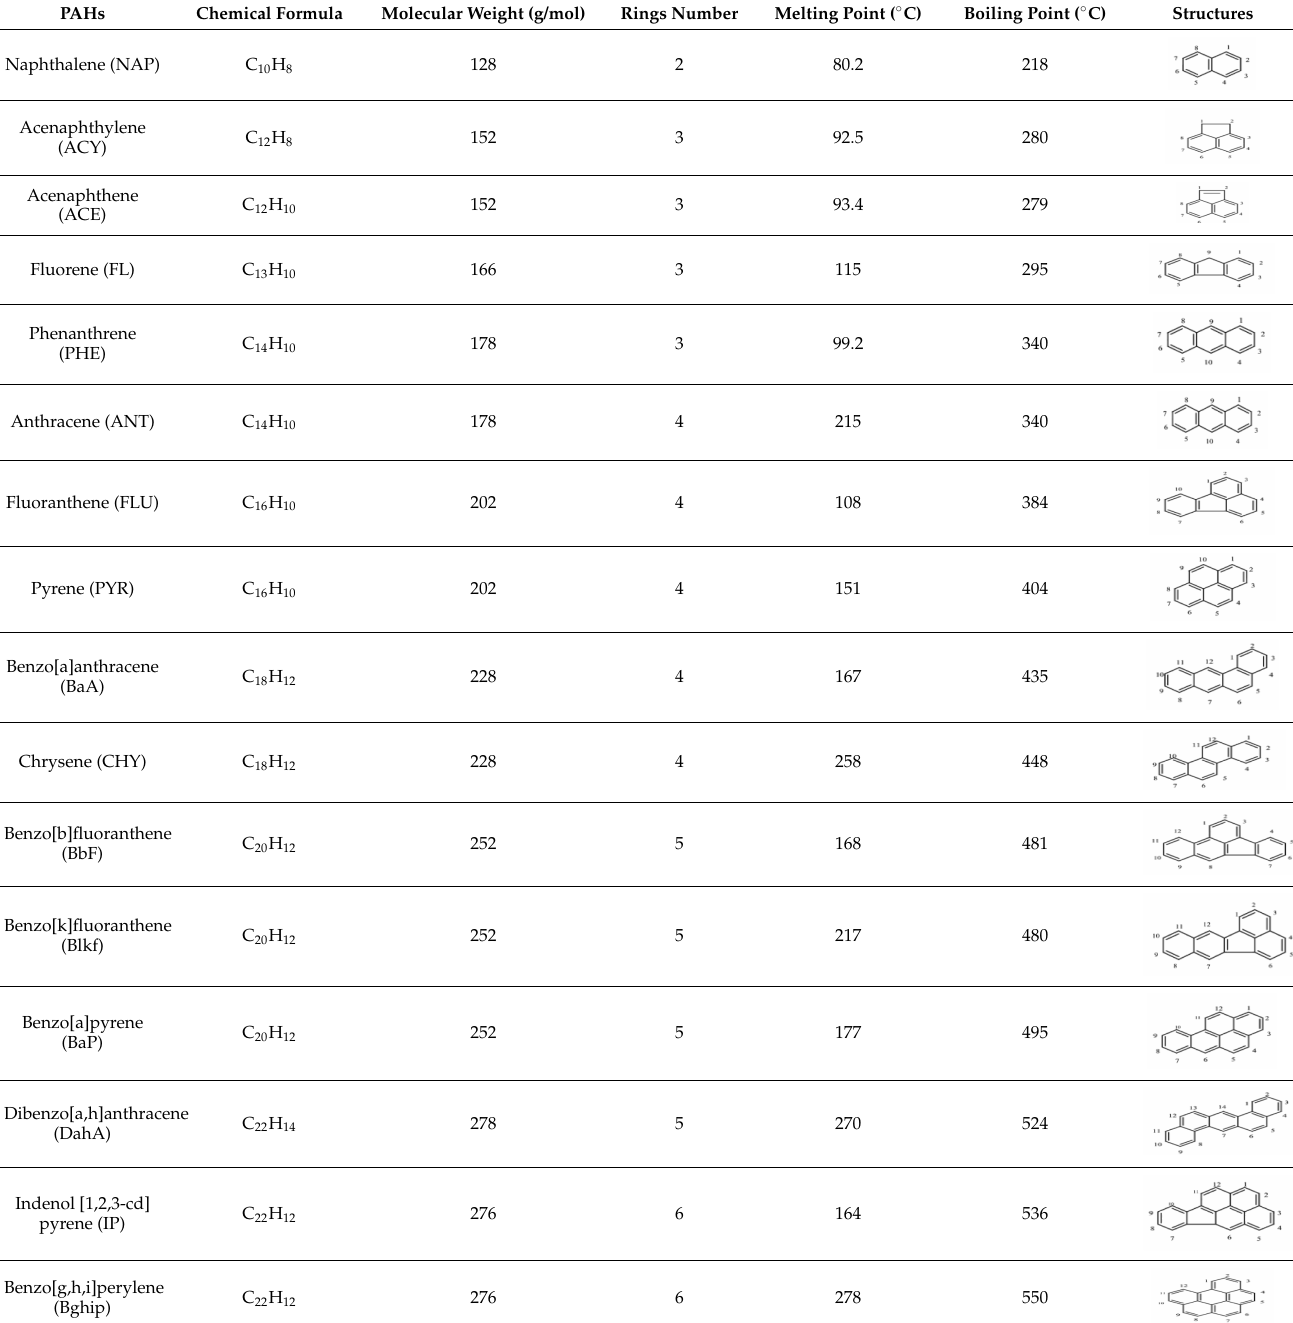
Table 1. The 16 PAHs that are commonly found in various water sources [13]. Copyright 2020, copyright owner’s A.O.